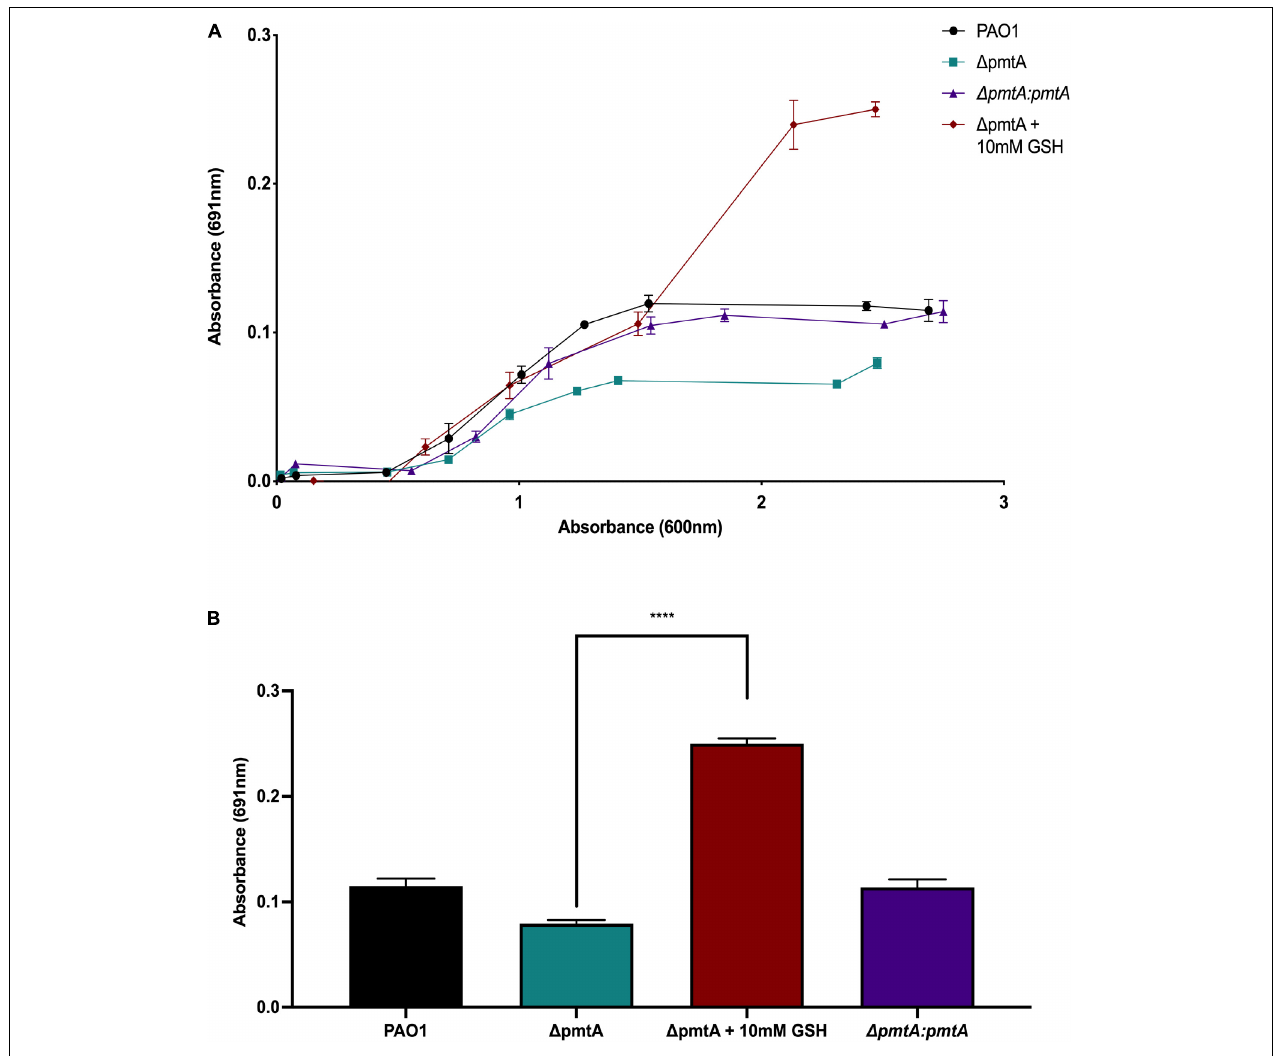
FIGURE 3 | Exogenous addition of the antioxidant glutathione restores pyocyanin production in the P. aeruginosa (cid:49) pmtA mutant. (A) The wild-type, (cid:49) pmtA , (cid:49) pmtA:pmtA and (cid:49) pmtA supplemented with 10 mM glutathione (GSH) PAO1 strains were cultured for 30 h at 37 ◦ C with vigorous shaking. Over the 30-h, the growth of the bacteria (OD 600 ) was compared to the production of pyocyanin in media (OD 691 ). The wild-type and (cid:49) pmtA:pmtA PAO1 strains produced more pyocyanin when compared to the (cid:49) pmtA mutant. Pyocyanin production of the (cid:49) pmtA mutant was restored to near wild-type levels starting at 8 h of growth. (B) The wild-type, (cid:49) pmtA , (cid:49) pmtA:pmtA, (cid:49) pmtA and (cid:49) pmtA supplemented with 10 mM glutathione (GSH) PAO1 strains were cultured in LB medium for 30 h at 37 ◦ C with vigorous shaking. At 30 h, pyocyanin was measured in the media (OD 691 ). The wild-type and (cid:49) pmtA:pmtA strains produced more pyocyanin when compared to the (cid:49) pmtA mutant. The pyocyanin production of the (cid:49) pmtA mutant was significantly increased with the addition of GSH. An unpaired t -test analysis was performed (* p < 0.05, ** p < 0.01, *** p < 0.001, **** p < 0.0001). The data are presented as the average of three biological replicates ( ± standard error of the mean) and are representative of three separate